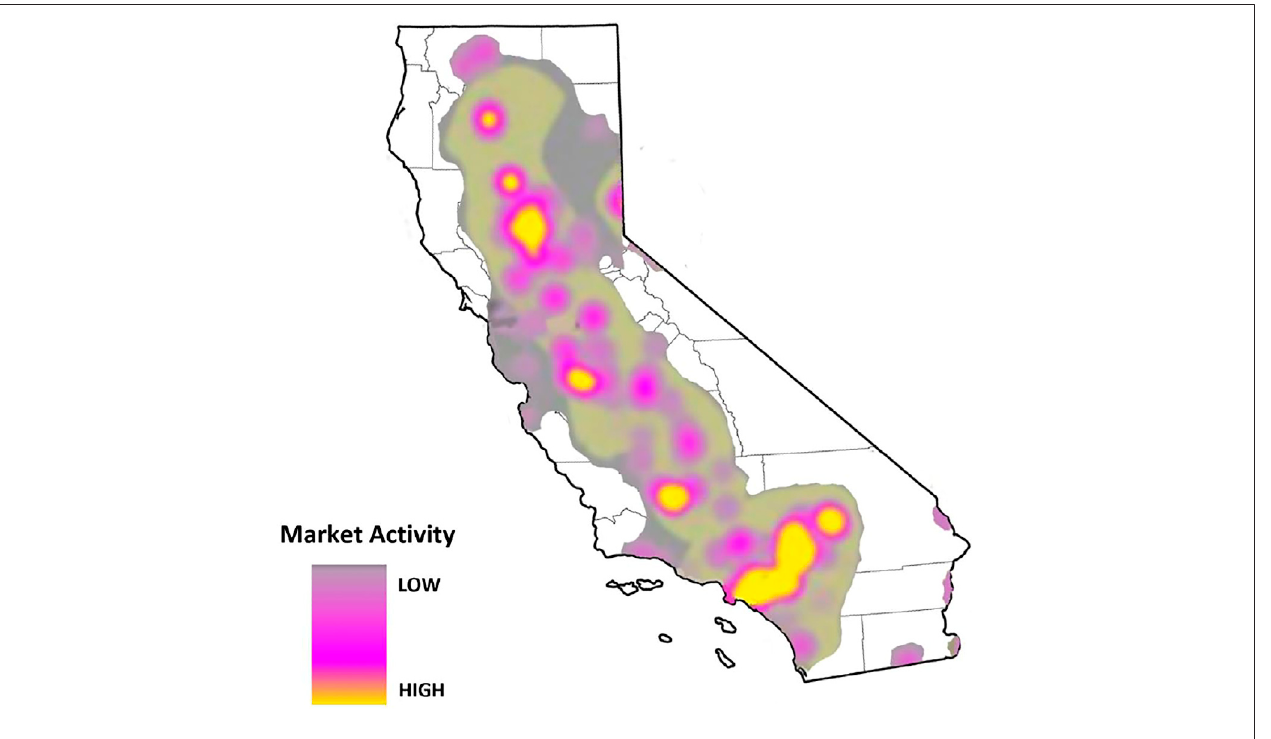
FIGURE 5 | Water market activity in California. Source: Nasdaq (2020).